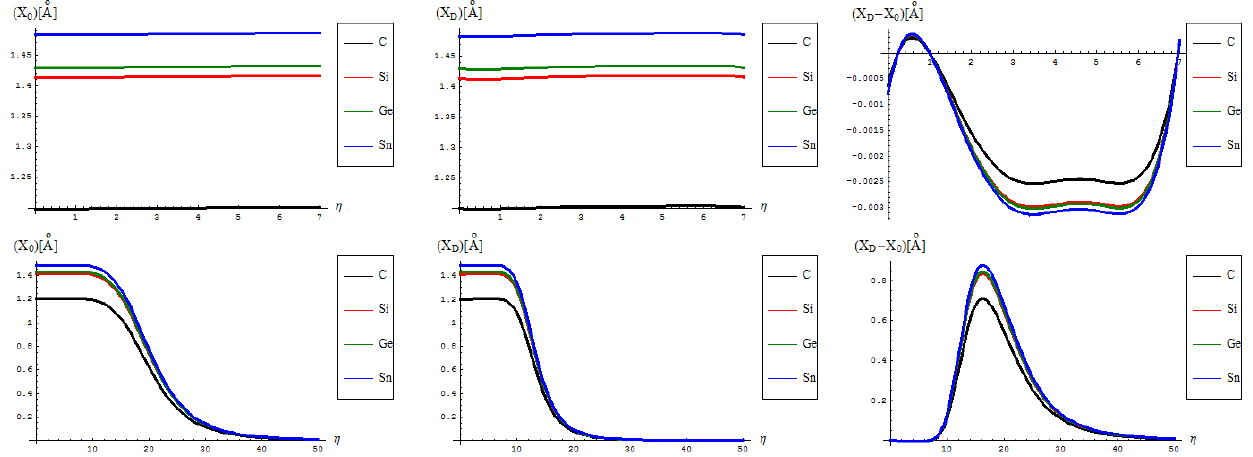
Figure 5. The bondonic “length” for SWw in forming (left column), defective propagation (middle column) along their differences (right column) behavior: on short (upper row) and long (lower row) ranges, upon considering critical information of Equation (16) into Equation